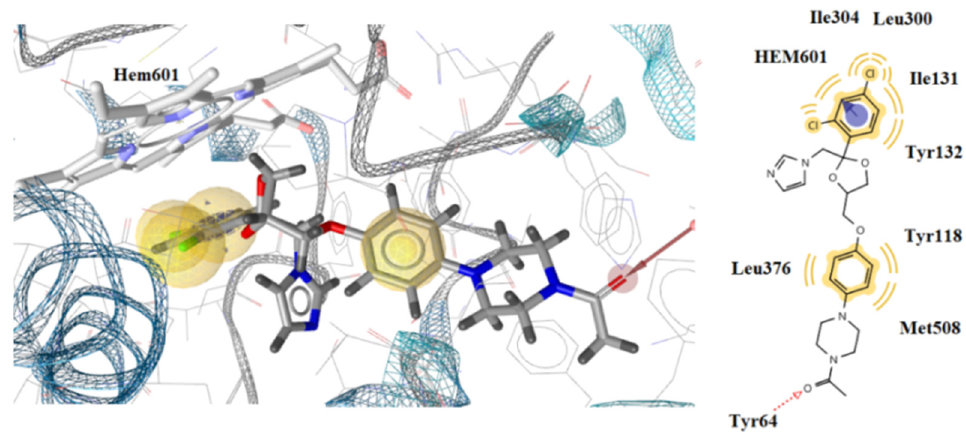
Figure 6. Docked conformation of ketoconazole in lanosterol 14 α -demethylase of C . albicans (CYP51 ca ).